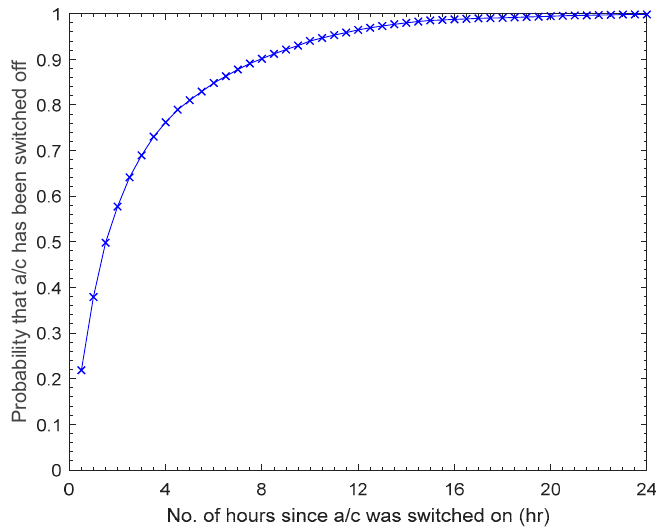
Figure 5. Cumulative probability function for a/c switch off-behaviour as a function of duration on.